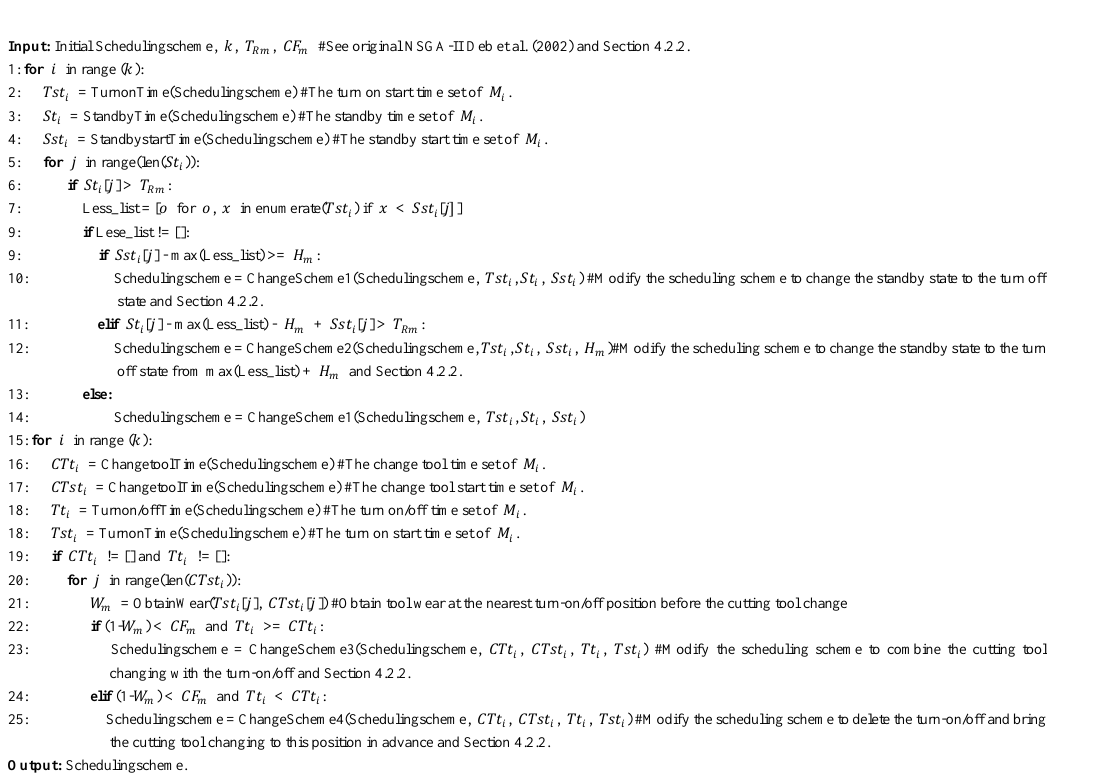
Figure 5. Hybrid mechanism algorithm form of cutting-tool change and machine tool turn-on/off.